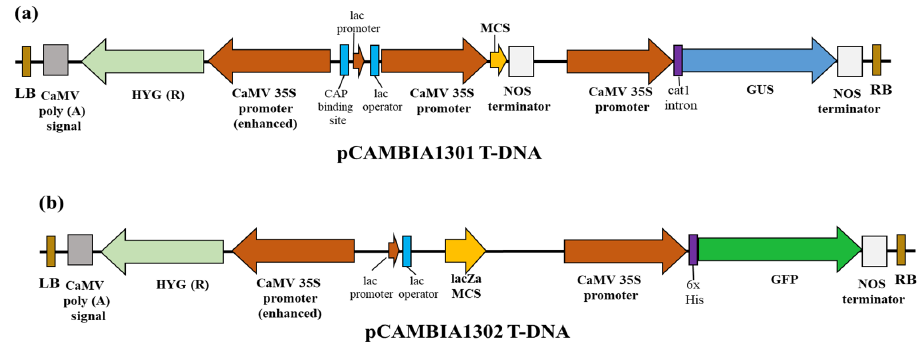
Figure 5. Expression vectors T-DNA regions. ( a ) pCAMBIA1301 plant expression vector T-DNA region containing GUS reporter and hygromycin resistance genes. ( b ) pCAMBIA1302 plant expression vector T-DNA region containing GFP reporter and hygromycin resistance genes.